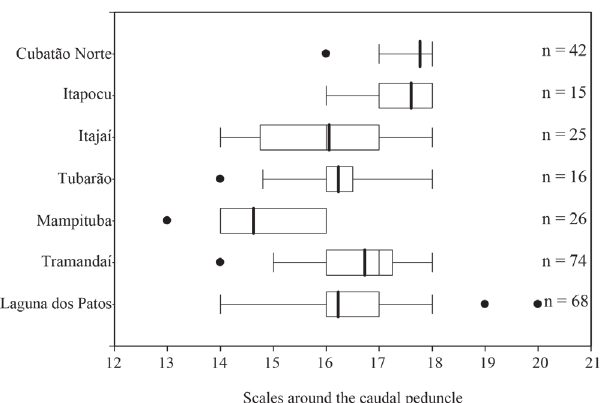
Fig. 10. Tukey box plots of number of scales around the caudal peduncle in Astyanax laticeps populations by river drainage from south to north. Mean represented by thick vertical bar and 25 th and 75 th percetiles as lateral borders of box plots.